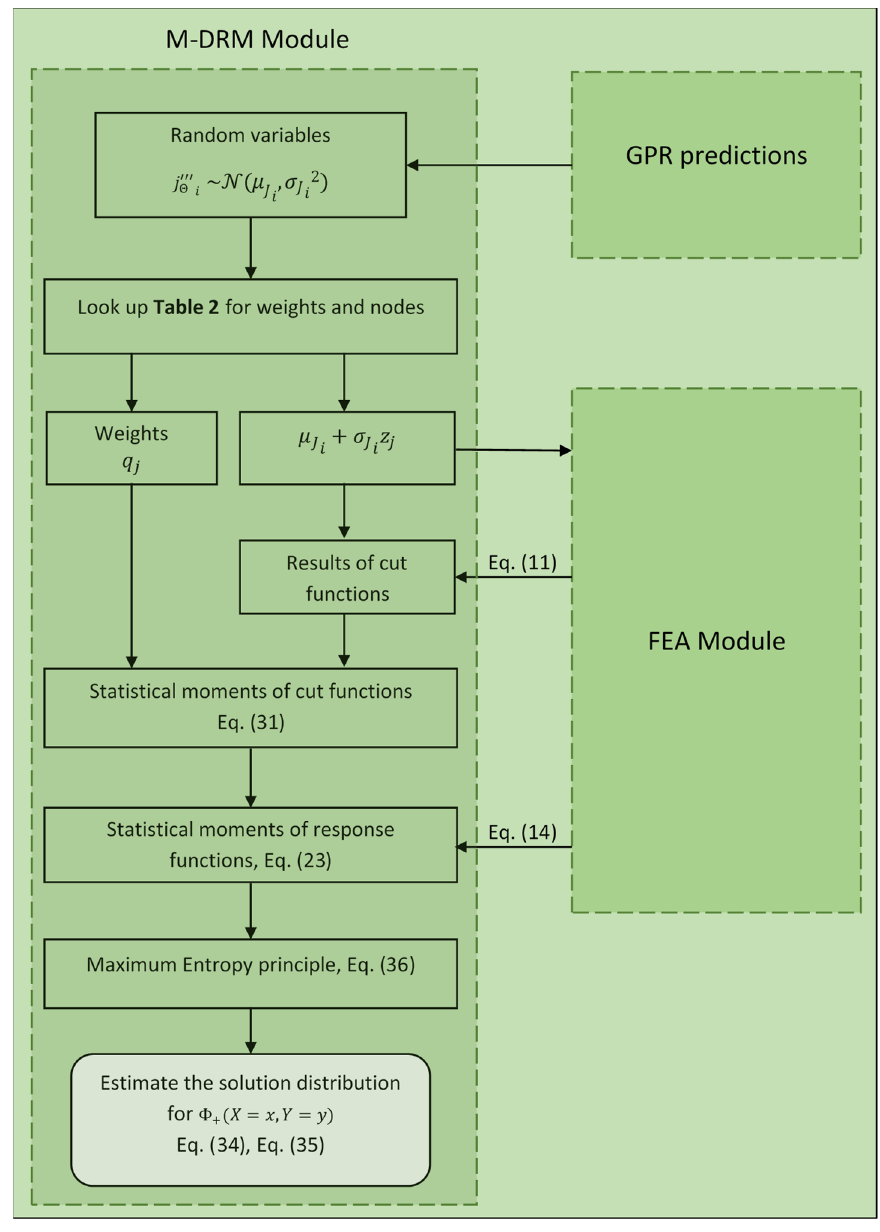
Figure 3. Solution process flowchart of the probabilistic FEAs resulting in the solution distribution of the positive electrode plate potential.